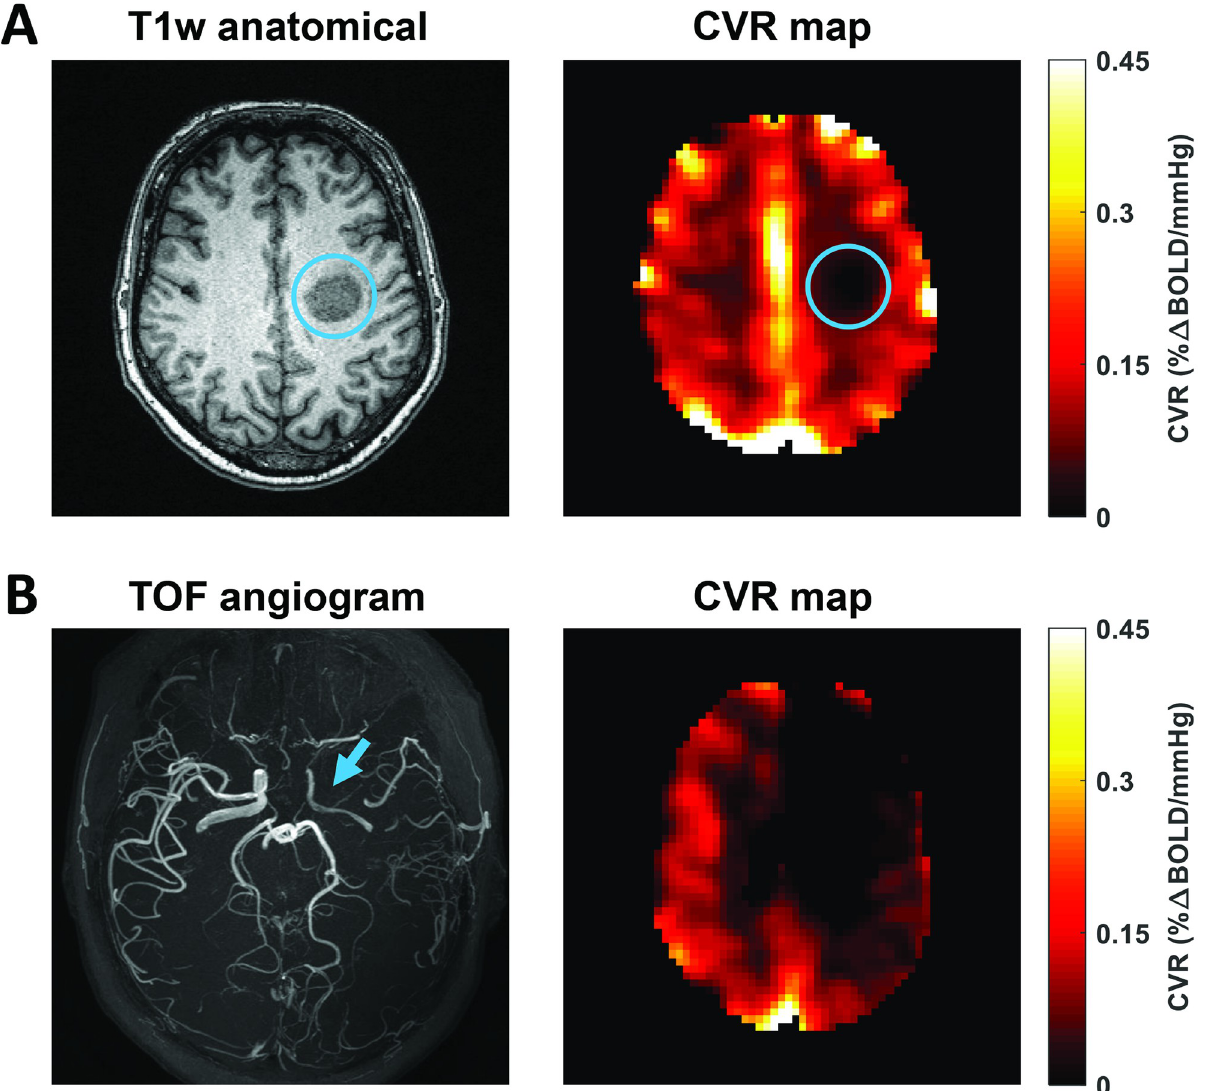
Fig 10. Examples of CO2-CVR maps in patients with brain disorders. (A) Anatomical image and CVR map from a patient with glioblastoma (58 years of age, male). Blue circles indicate tumor region. BOLD imaging parameters were: TR/TE = 1550/21ms, resolution = 3.2x3.2x3.5mm 3 , 362 dynamics. (B) Time-of-flight angiogram and CVR map from a patient with Moyamoya disease (55 years of age, female). Blue arrow indicates right MCA stenosis. BOLD imaging parameters were: TR/TE = 1510/21ms, resolution = 3.2x3.2x4.2mm 3 , 372 dynamics.